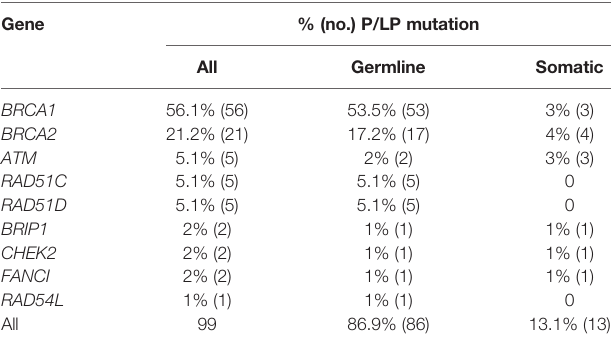
TABLE 3 | Statistics on the prevalence of estimated germline/somatic mutations among 99 deleterious mutation in each HRR gene. Gene % (no.) P/LP mutation